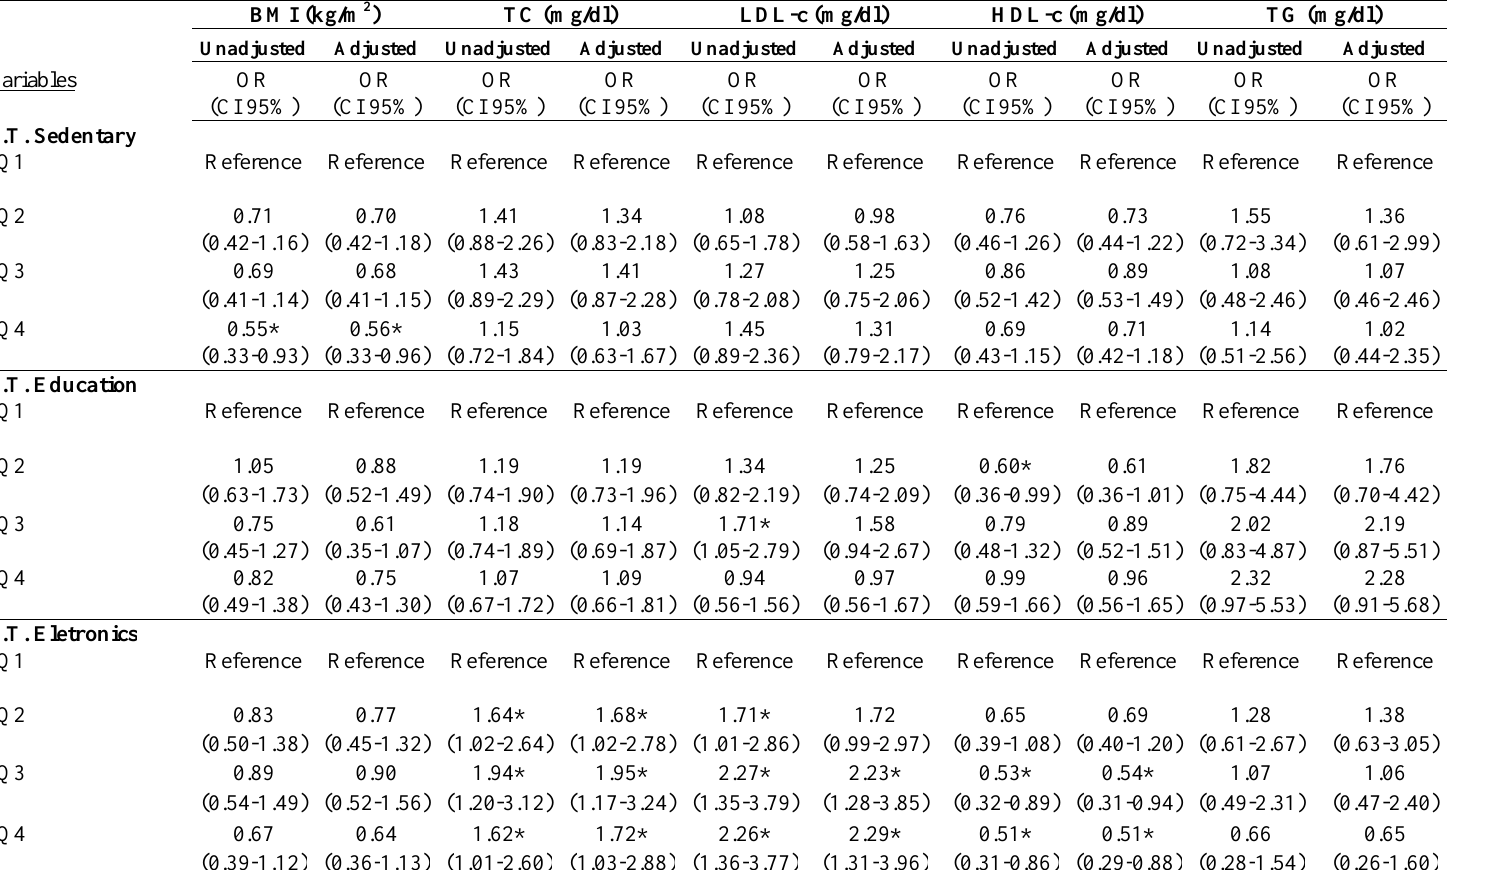
Table 3. Odds Ratio for BMI and metabolic profile alterations caused by the total time spent on sedentary behavior